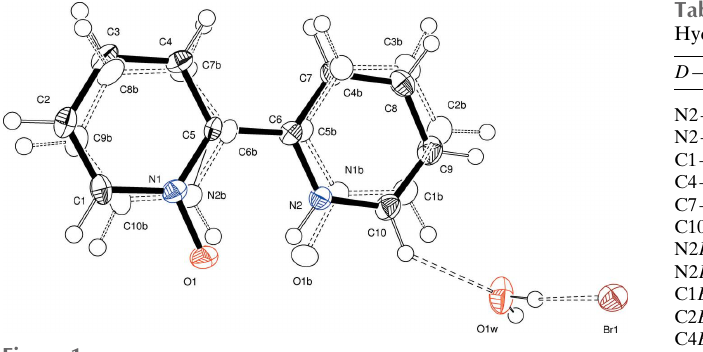
Figure 1 Molecular structure of the cation of the title compound. Non-hydrogen atoms showing displacement ellipsoids with octand shading represent the major component of the two disordered